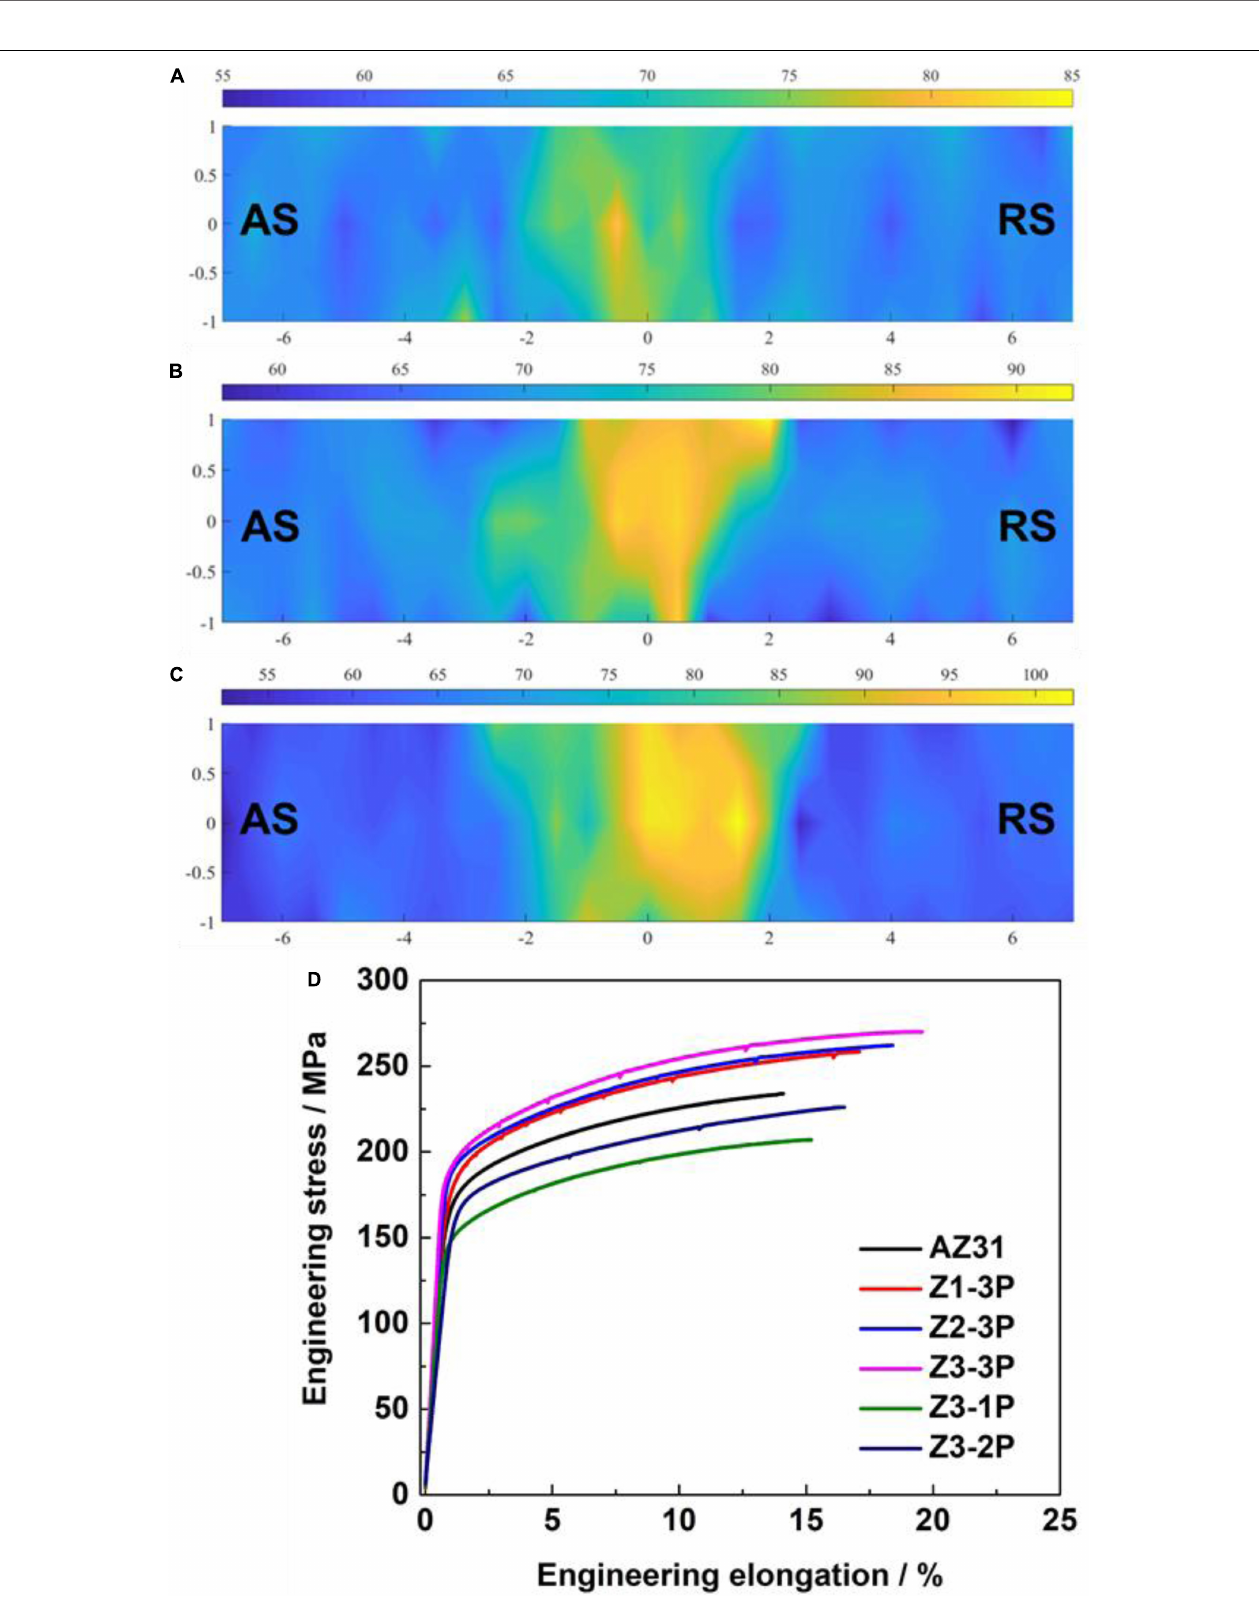
FIGURE 10 | Microhardness mapping of (A) Z1-3P specimen, (B) Z2-3P specimen, (C) Z3-3P specimen, and (D) engineering stress–strain curves of AZ31 alloy and FSPed AZ31/ZrO 2